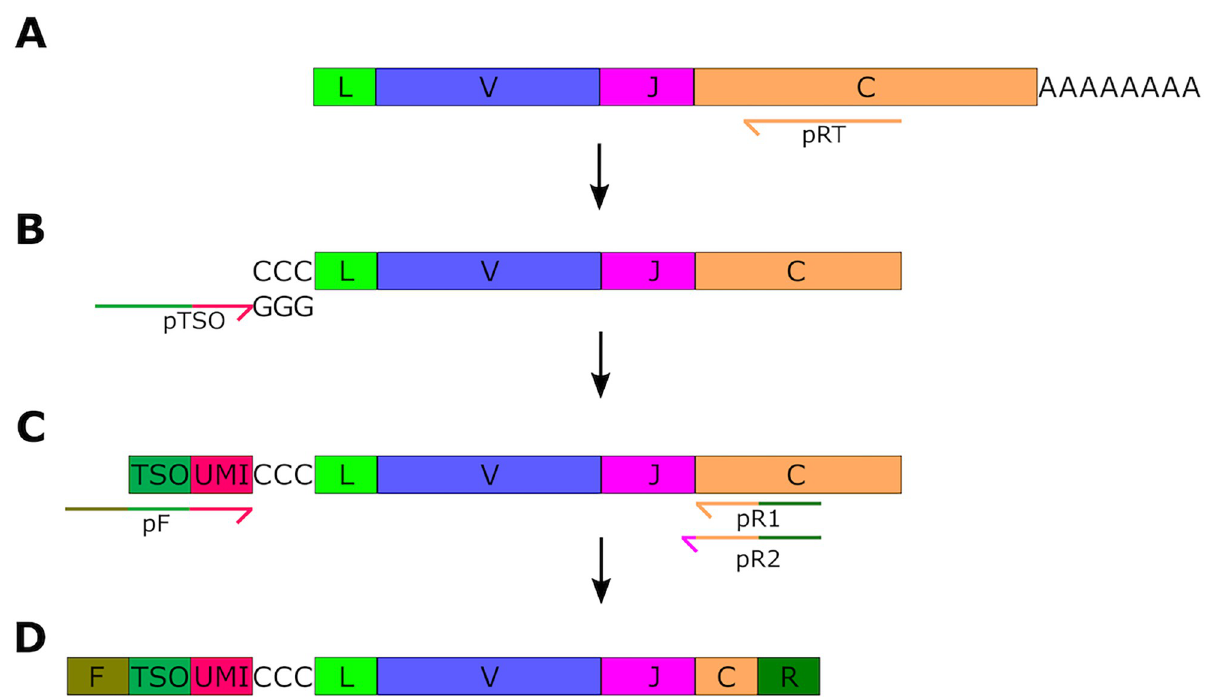
Fig 1. Library preparation using 5’ Rapid Amplification of cDNA Ends (5’ RACE). (A) Antigen receptor mRNA is reverse-transcribed using primers (pRT) that anneal to the constant region (orange box), using a polymerase that adds non-templated cytidines to the 3’ end of the cDNA. (B) The template switch oligo (pTSO) then anneals to these cytidines and provides a template that is extended by the reverse-transcriptase to yield a reverse strand cDNA copy of the transcript incorporating the TSO sequence. (C) This template is then amplified using a forward primer (pF) that anneals to the TSO sequence (green box), upstream of the UMI (red box) added by the TSO, and reverse primers (pR1 and pR2) that anneal to the constant region sequence adjacent to the JC boundary. Reverse primers anneal flush to the JC boundary (pR1) or include a few nucleotides of J region sequence (pR2). The primer sequences also include the adapter sequence for the sequencing platform, in this case the Illumina adapters (green region on pF, pR1, and pR2). (D) Amplification yields a product that spans the V(D)J region and a small amount of C sequence, with a UMI at the 5’ end and adapter sequences at both ends (F and R, green